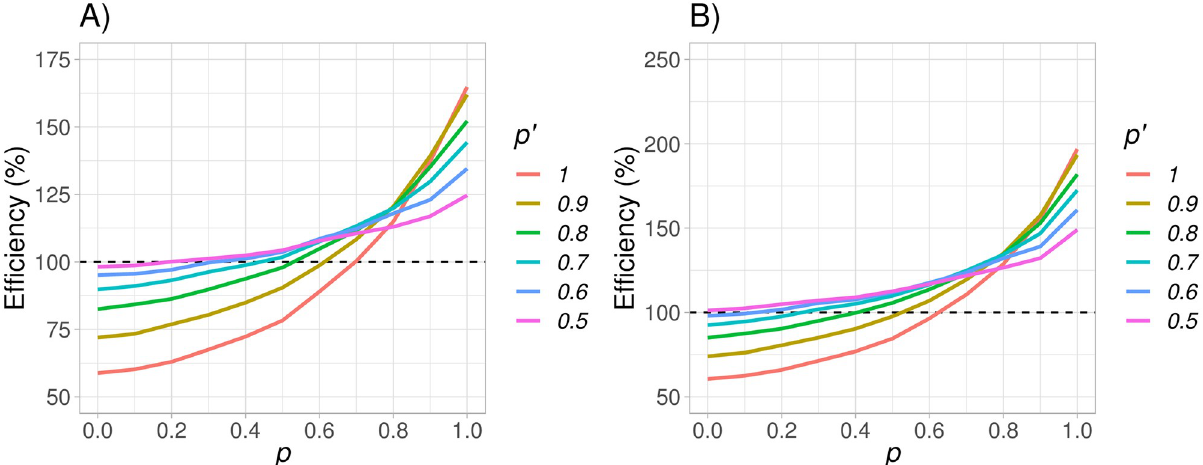
Fig 10. Efficiency between the modified weighted log-rank test ( mWLR ) with respect to the test based on the restricted mean survival time (plot A), and efficiency between mWLR test with respect to the Max Combo test (plot B) assuming a fixed value of m OS 0 and 1, and p 0 between 0.5 and 1. Values of efficiency over 100% favor the mWLR test and values below 100% favor the test based on the restricted mean survival time or the Max Combo test.